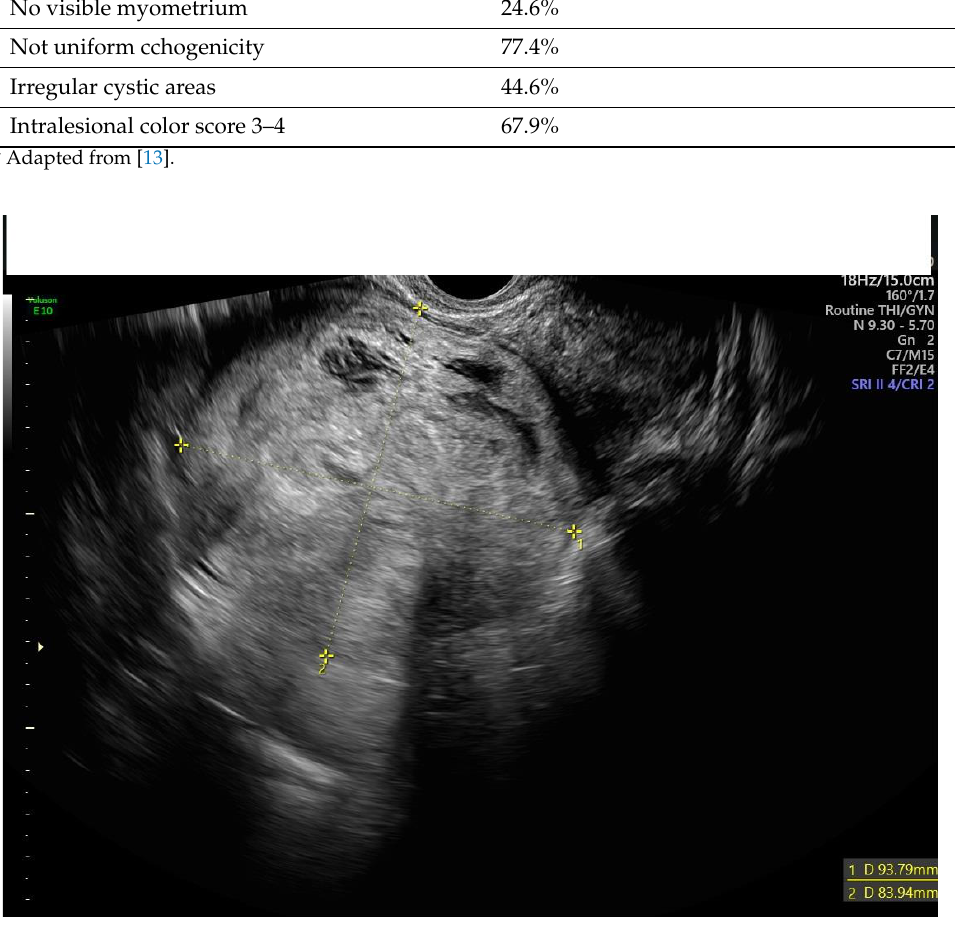
Figure 1. Transvaginal ultrasound of a myoma with no uniform echogenicity.